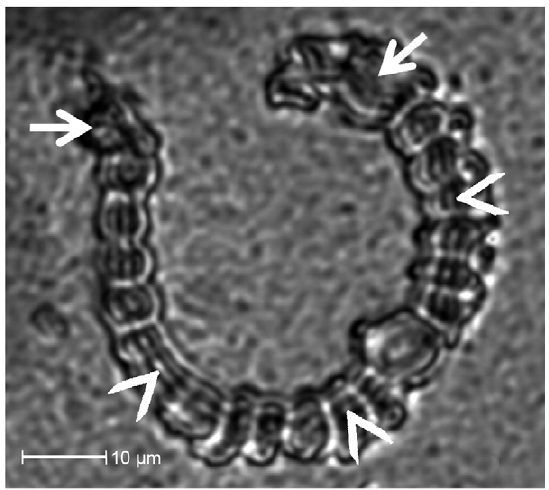
Figure 3. Optical sectioning by CLSM through a salivary sheath of M.viciae . The salivary sheath is attached along its whole length of 106 m m to the lower side of Parafilm membrane that covered a feeding chamber filled with ST diet. The site of stylet penetration through the Parafilm is located on the right end of the salivary sheath (right arrow). The sheath has a typical pearl-necklace like structure and narrows slightly towards the tip (left arrow). The empty stylet canal is visible inside the salivary sheath (indicated by arrowheads) with exception of the very first segment (right arrow).